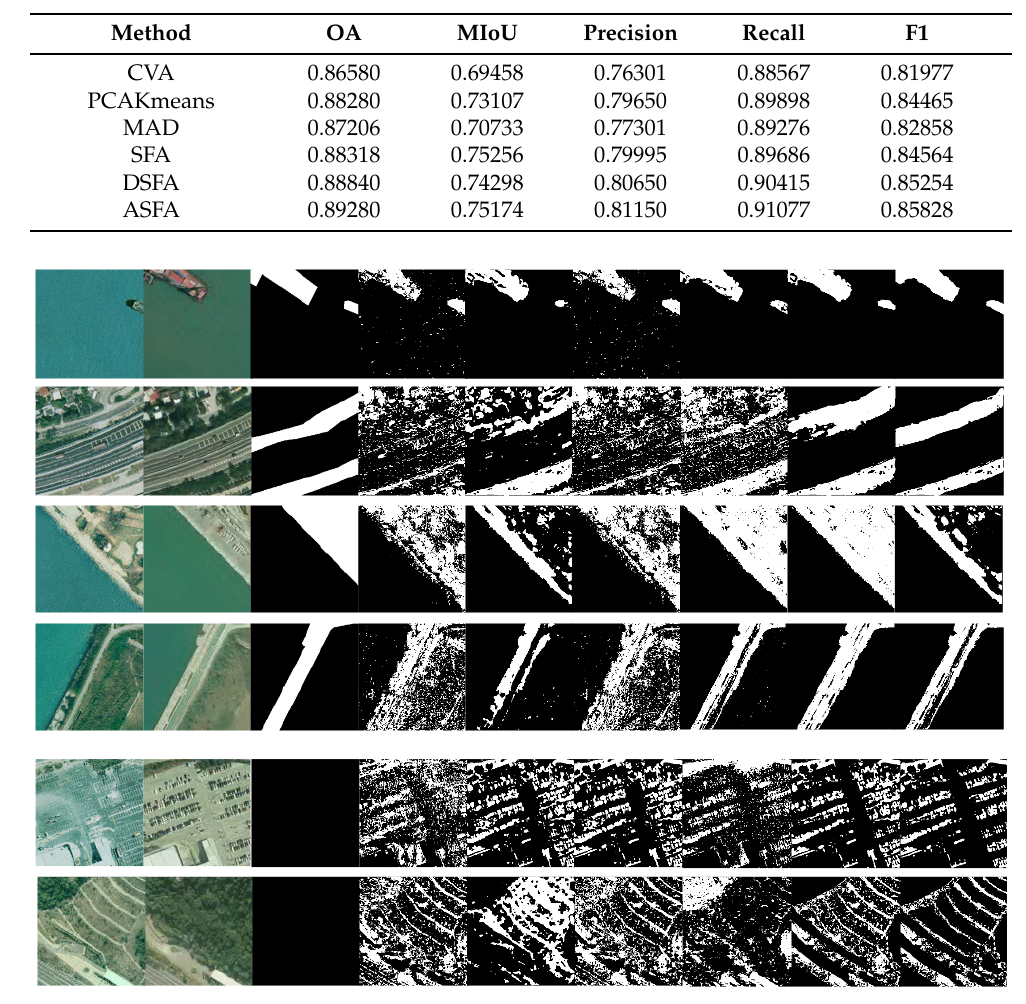
Table 12. The comparative experiment results on SYSU-CD.